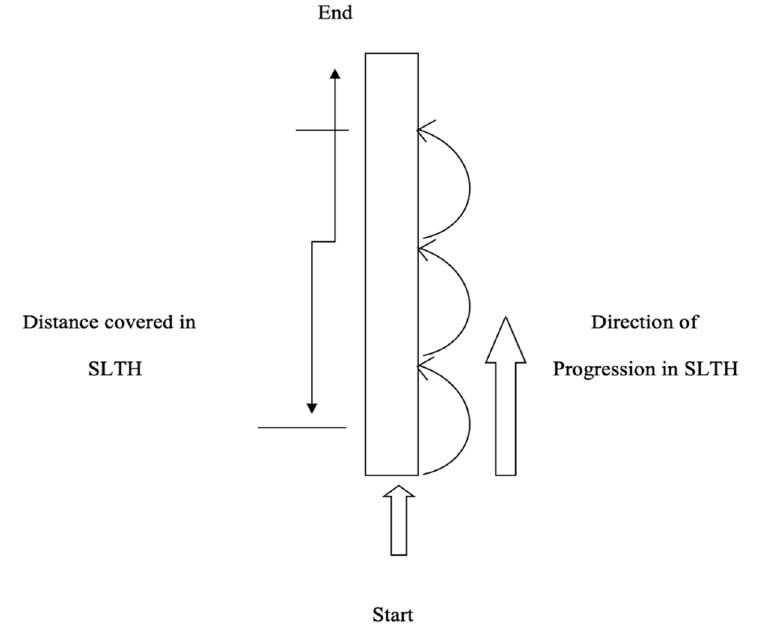
Figure 3. Illustration of Single-Leg Triple Hop test (SLTH).